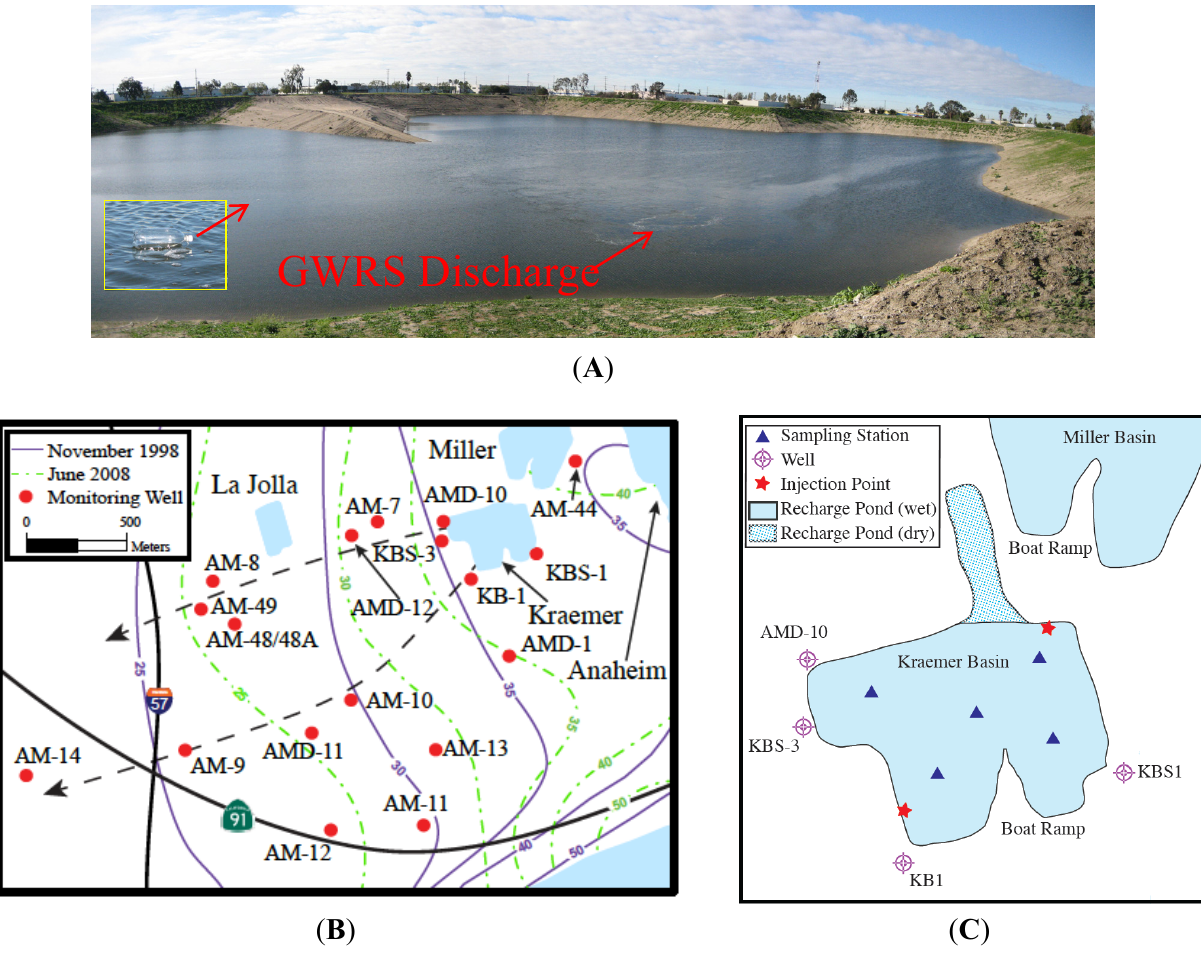
Figure 2. Maps of the Orange County MAR facilities. ( A ) Photograph of the basin looking from the northern shore to the south towards the boat ramp. The inserted photo shows one of the fixed buoys; ( B ) Detailed map of the January 2008 field area showing the sampled wells and principle recharge areas. At the start of the experiment, neither Miller nor La Jolla Basins were recharging the aquifer. For reference, the north-south 57 freeway and the east-west 91 highway have been included. The black dashed arrows represent the northern and southern flow lines, the solid purple and dashed/dotted green contours represent, respectively, the and November 1998 and June 2008 piezometric surfaces; ( C ) Detail of Kraemer Basin at the time of the 2008 tracer injection showing where tracer was introduced and